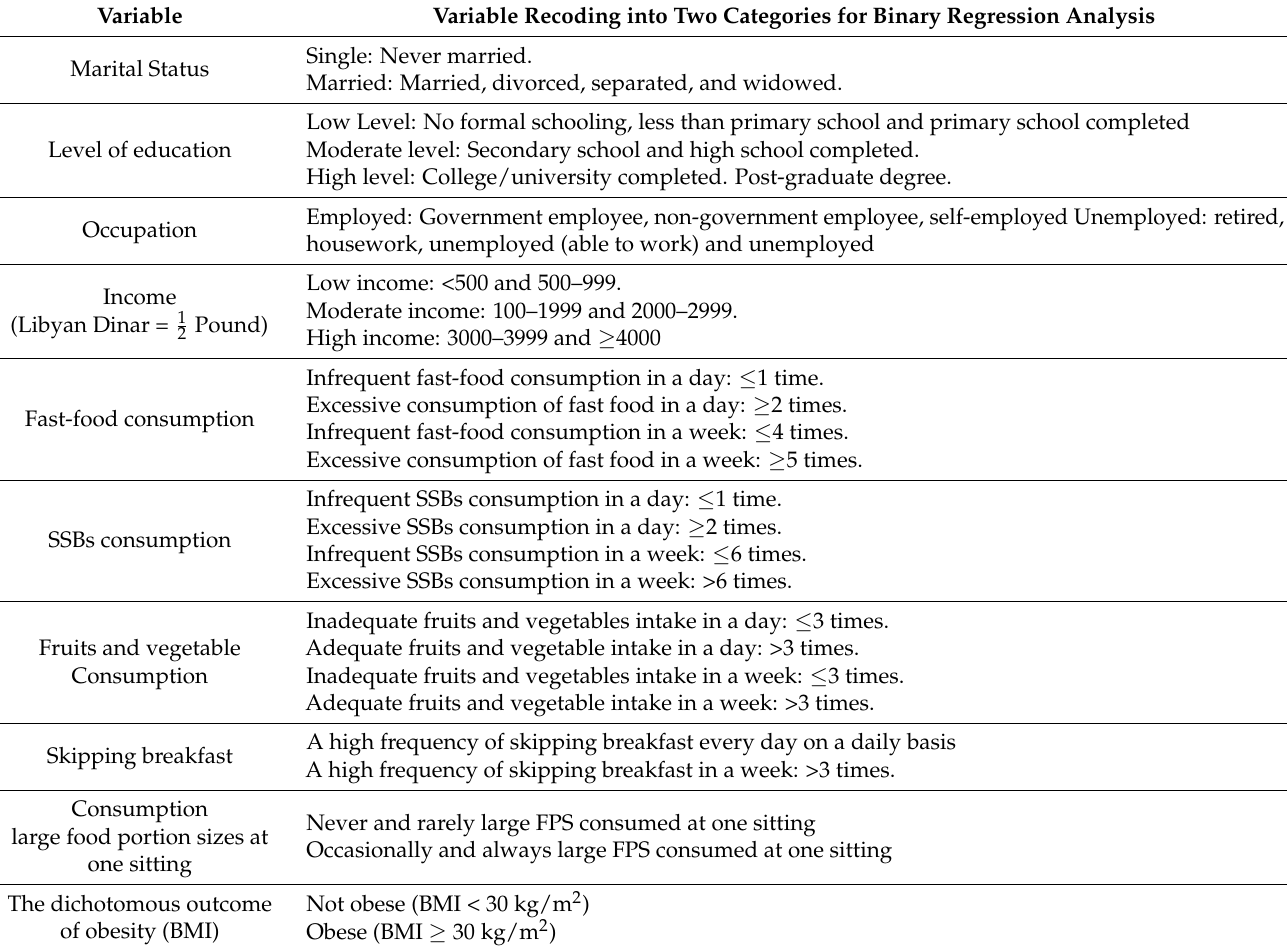
Table 1. Grouping and Recoding